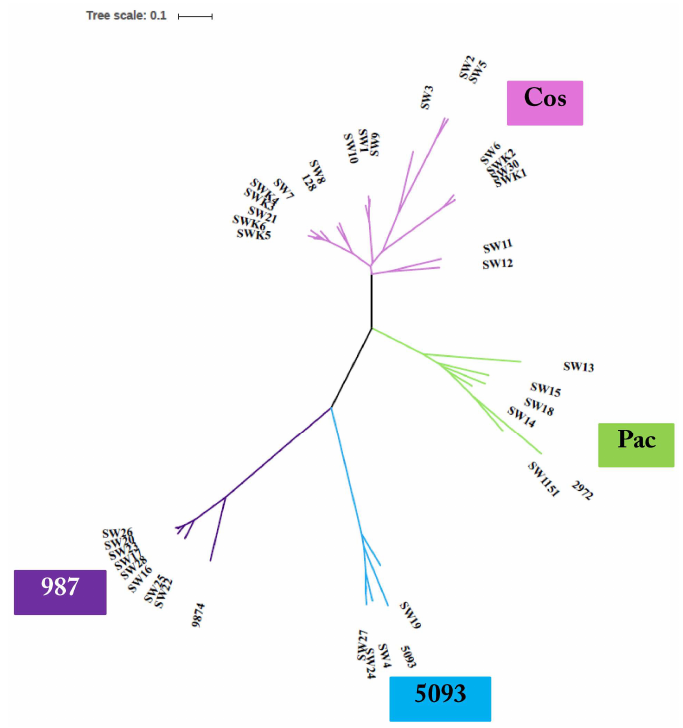
Figure 1. Unrooted phylogenetic tree of phage isolates and including representatives of each of the four described phage groups. The cos phages display most genetic diversity while the 987 and 5093 groups exhibit high genomic conservation irrespective of geographical background. Note: SW13, SW31, SW32, and SW33 are 100% identical. Therefore, this group of isolates is represented by SW13 on the phylogenetic tree for